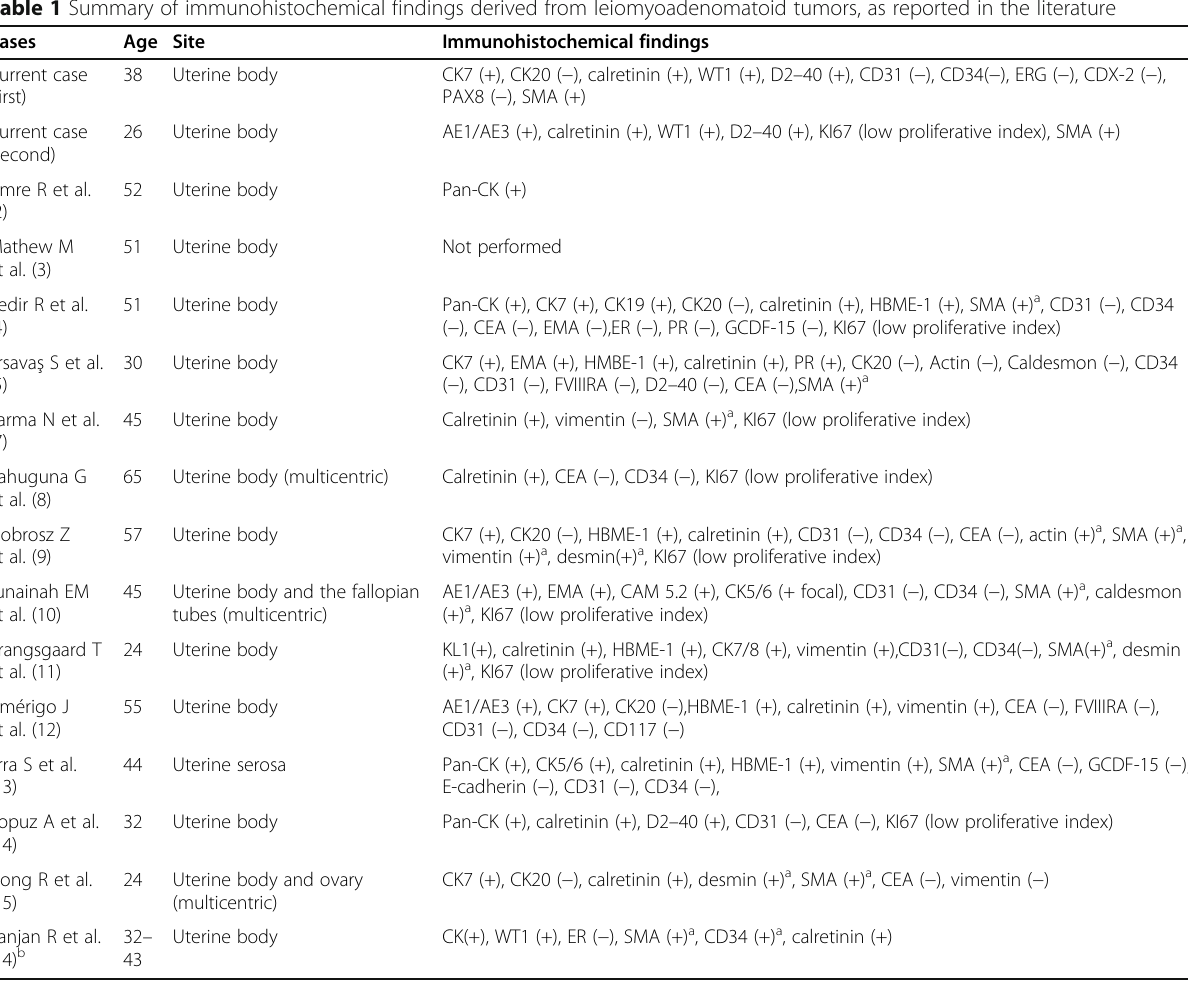
Table 1 Summary of immunohistochemical findings derived from leiomyoadenomatoid tumors, as reported in the literature Cases Age Site Immunohistochemical